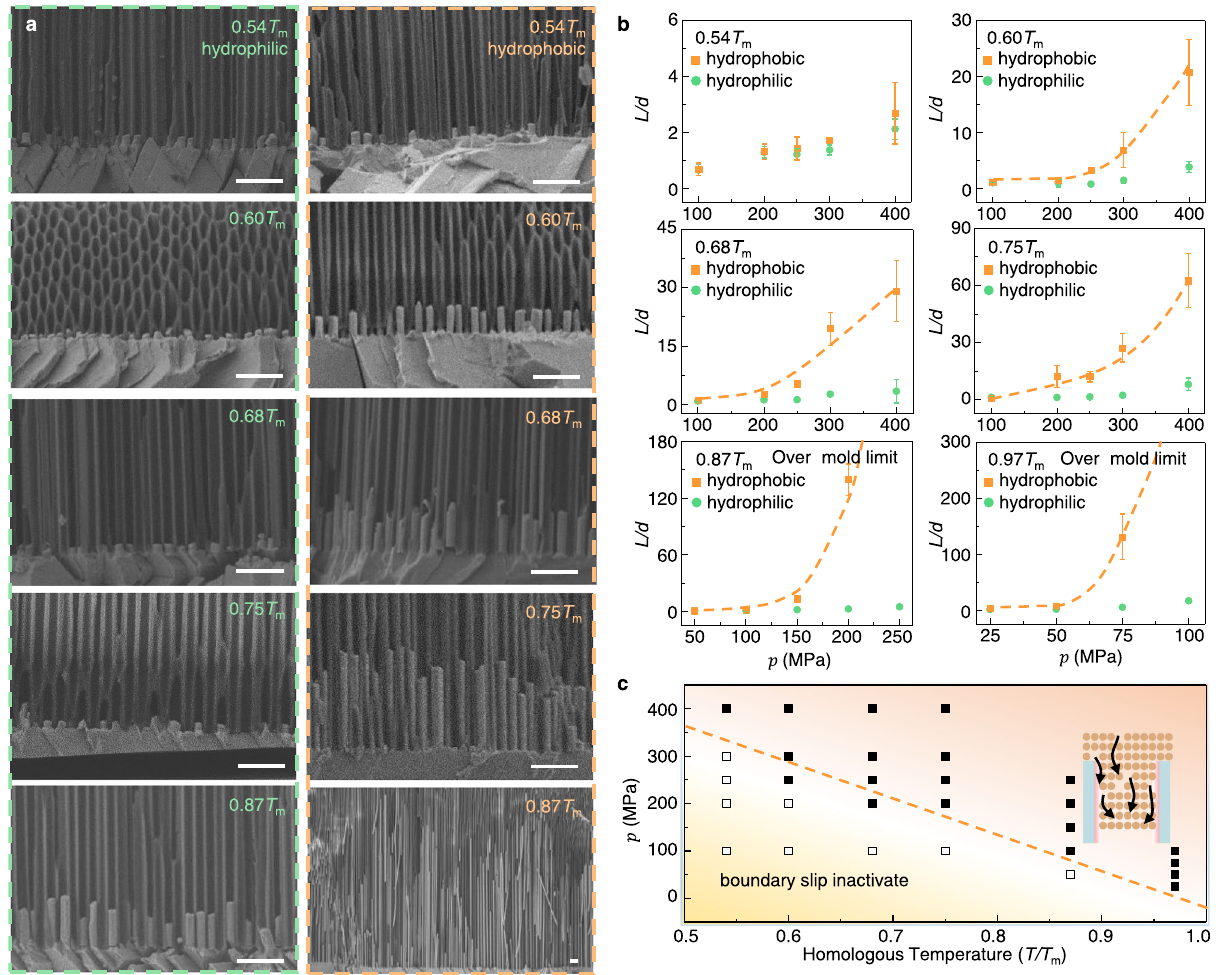
Fig. 3 | Temperature dependence of higher creep fl ow of Bi enabled by super- hydrophobicsurface.a SEMcharacterizationofBinanowiresmoldedwithpristine (left fi gures) and silanization-treated AAO nanomolds (right fi gures, see “ Meth- ods ” "), where the molding pressure was linearly increased from zero to 250 MPa witha loading rateof10MPa/s, andAAOnanomolds with cavitysizeof d =300nm wereused.Scalebars:2 μ m. b MeasuredlengthofBinanowiresmoldedatdifferent pressure and temperature. The dashed lines are given as guides to the eye. c The